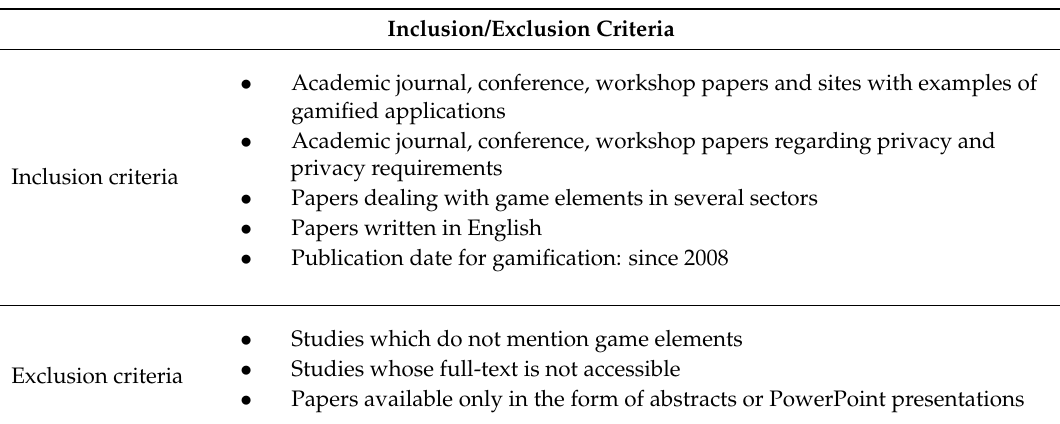
Table 4. Summary of the selection